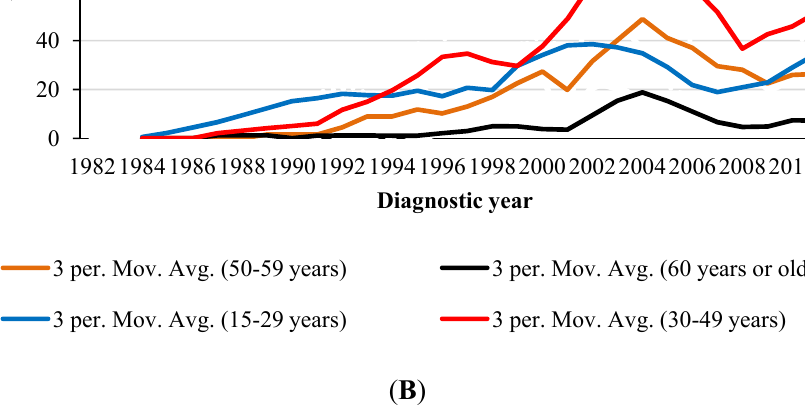
Figure 1 shows the trend in AIDS incidence rates by period in different age groups from